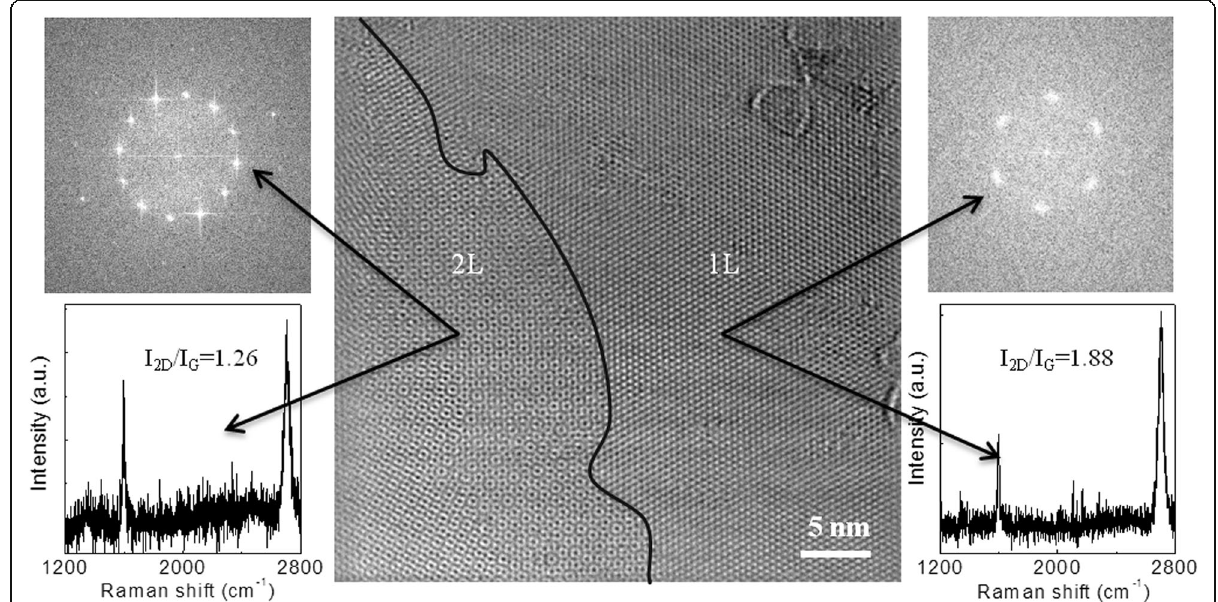
Fig. 3 TEM analysis of a CVD-grown graphene flake from ethanol prepared with 4-h growth time, taken from Fig. 2b. High-resolution TEM image showing both monolayer and bilayer regions separated by marked line. Monolayer region contains some defects, which is localized. Moiré patterns as a result of rotational misalignment of the two graphene layers are clearly seen in the bilayer region. The right and left panels of the TEM image display the Fourier transform of the electron diffraction patterns of 1L and 2L graphene. Hexagonal selected area electron diffraction patterns of the monolayer and bilayer graphene reveal the nice crystallinity. Their representative Raman spectra are illustrated in the bottom panel with I 2D / I G ratio of 1.88 and 1.26 for 1L and 2L,